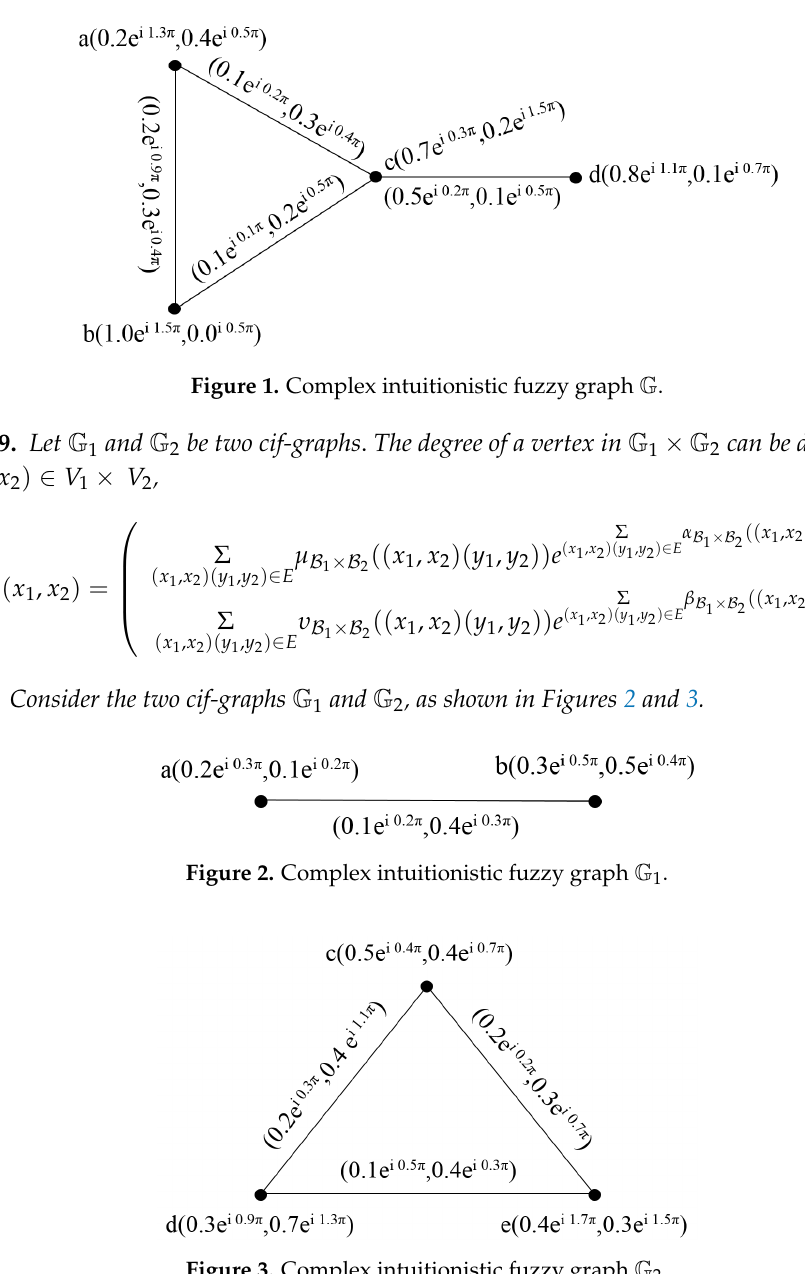
Figure 3. Complex intuitionistic fuzzy graph G 2